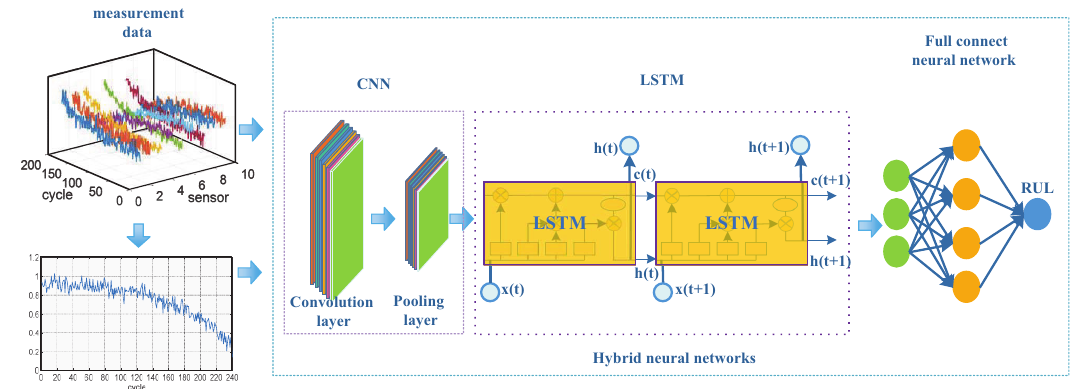
Figure 6. Hybrid neural networks for RUL